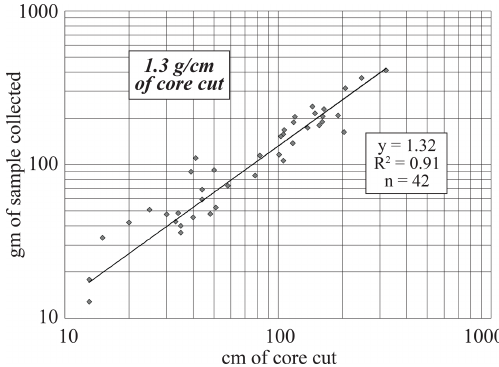
Figure 2. The relationship between total grams of sample collected and centimeters of core cut, illustrating that the sampling methods were systematic and that ∼ 1.3gcm − 1 of cut core was recovered from this process.